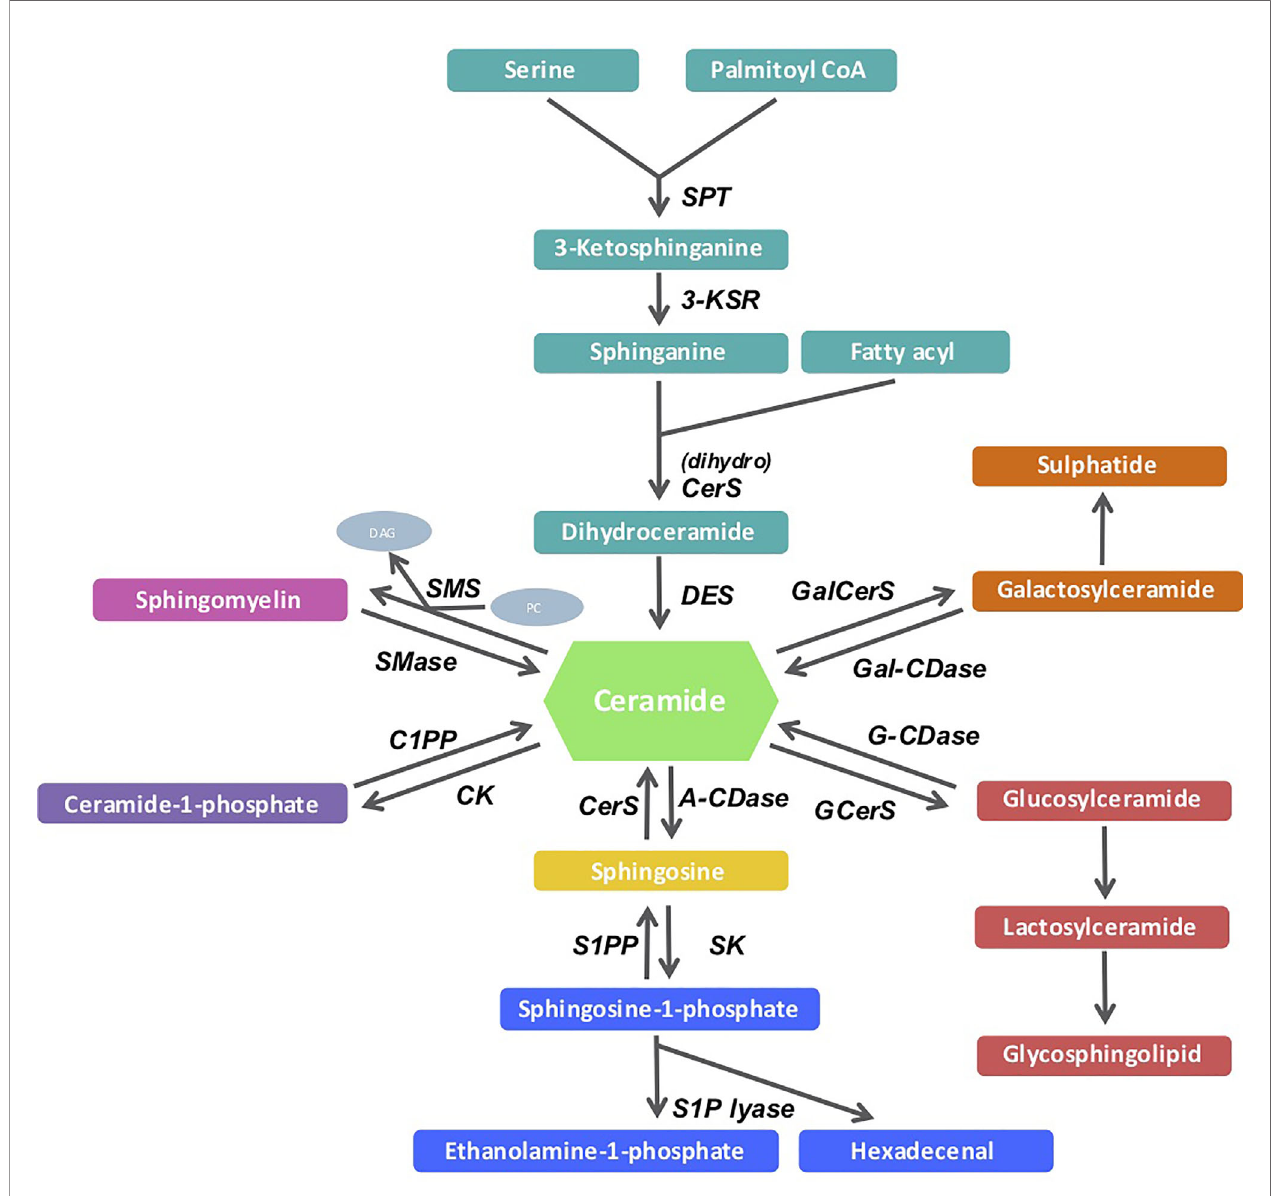
FIGURE 1 | Sphingolipid metabolism pathway. De novo (light green arm) sphingolipid biosynthesis begins with the condensation of serine and palmitoyl-CoA, which is catalyzed by the serine palmitoyltransferase enzyme. Its product, 3-ketosphinganine is enzymatically reduced to sphinganine or dihydrosphingosine by 3- ketosphinganine reductase. Sphinganine and fatty acyls then synthesize dihydroceramides under the regulation of the dihydro ceramide synthases (CerS) that are then reduced by dihydroceramide desaturase to produce ceramides of different acyl-chain lengths. Ceramide can also be metabolized via other enzymes in the salvage (light blue and pink arms), sphingomyelin hydrolysis (dark green arm)